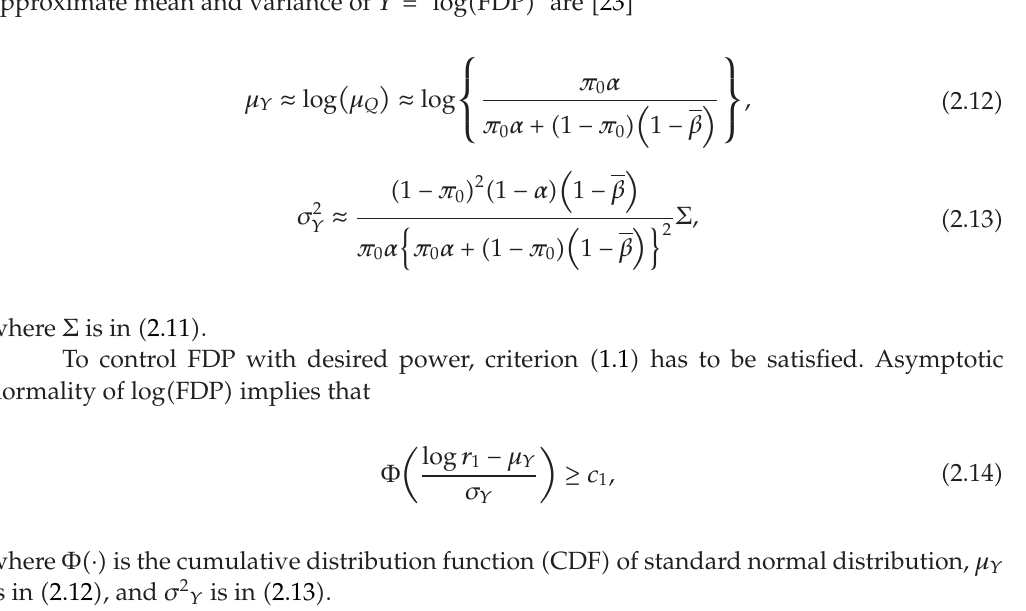
method, and under weak dependence log (cid:2) FDP (cid:3) is closer to normal than the FDP itself. The approximate mean and variance of Y (cid:8) log (cid:2) FDP (cid:3) are (cid:5) 23